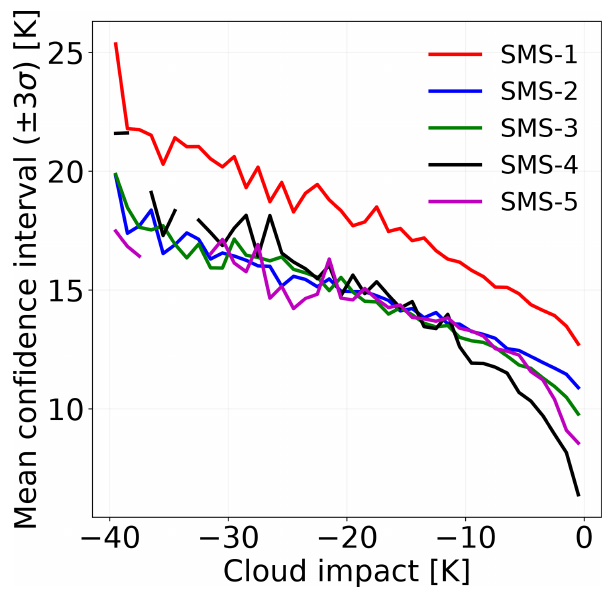
Figure 13. The average confidence intervals ( ± 3 σ ) plotted against the magnitude of cloud impact for all SMS